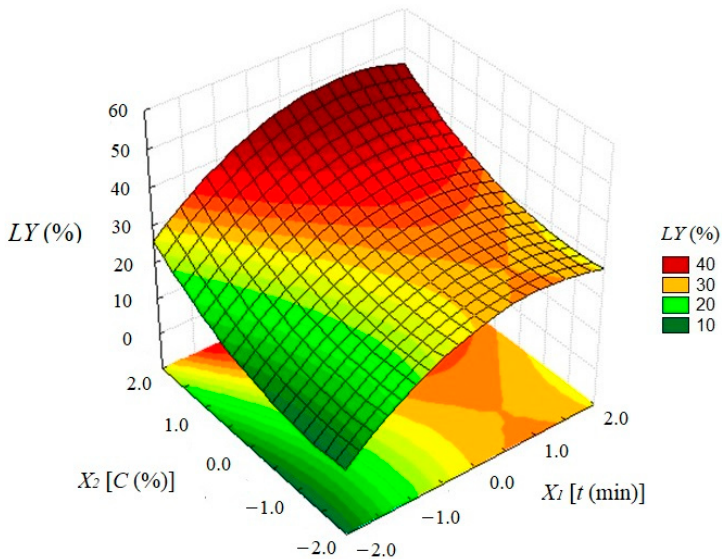
Figure 5. Liquid yield as a function of reaction time ( X 1 ) and percentage of catalyst ( X 2 ).